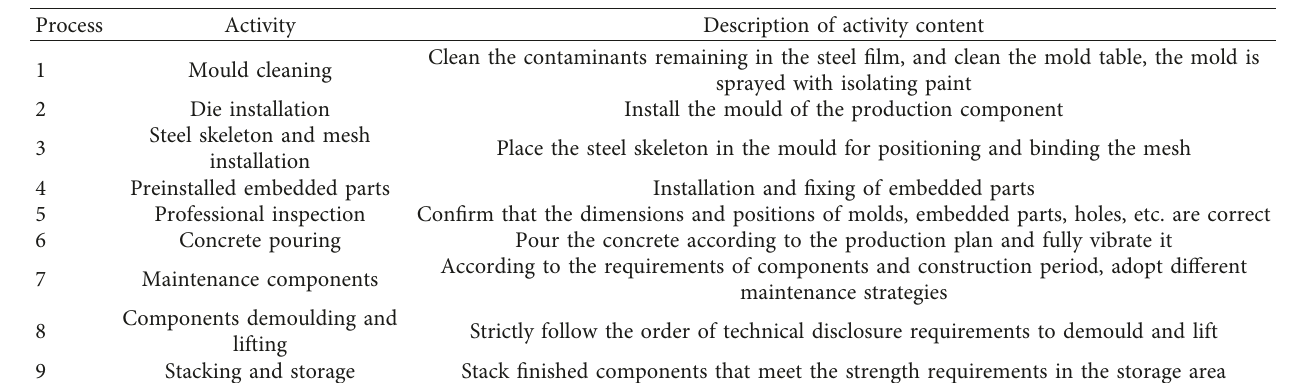
Figure 1: Process flowchart of prefabricated component production. Table 1: The work content of the specific